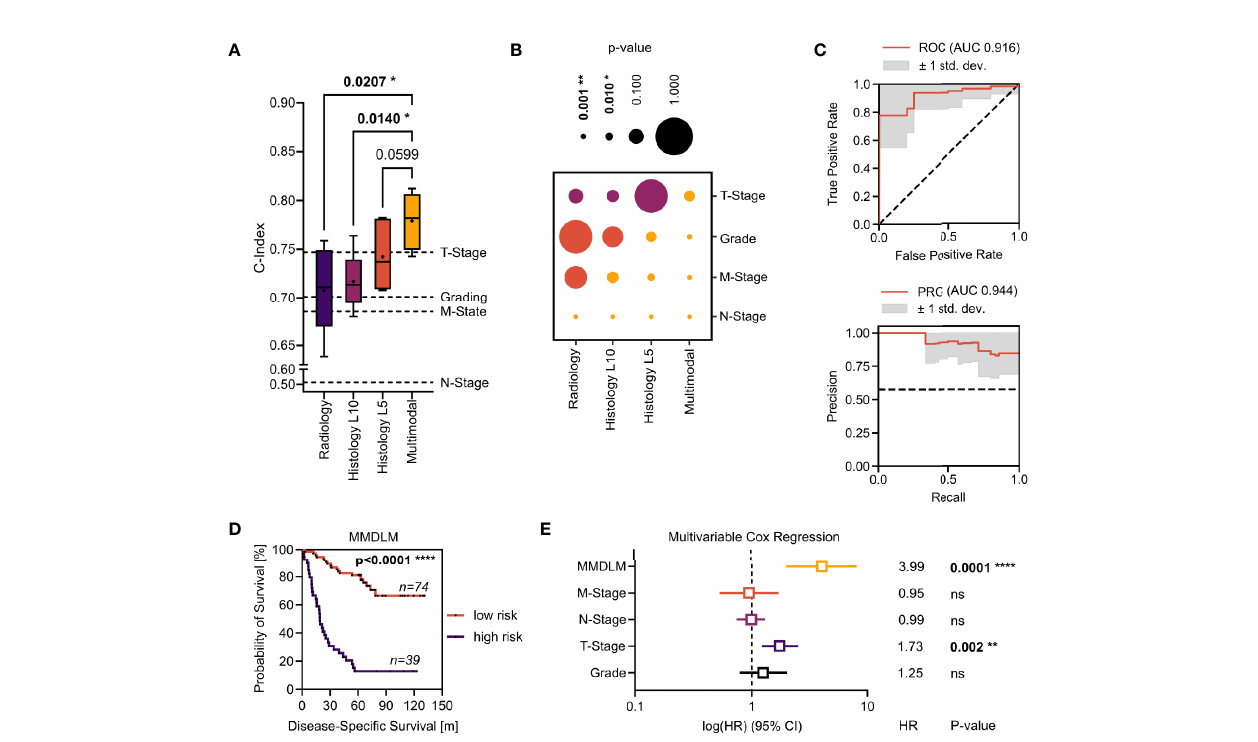
FIGURE 2 | Evaluation of the MMDLM for prognosis prediction in ccRCC. (A) C-index distribution of 6-fold cross validation. Dotted lines represent the C-index of the respective clinical attribute (Grading, T-Stage, N-Stage, M-Stage) of the whole cohort. RM one-way ANOVA with post-hoc Tukey HSD to correct for multiple comparisons was used to compare the groups. (B) P-value matrix of one-sample t test of each modality vs. each risk factor (yellow: signi fi cantly. higher, orange: higher, purple: lower). (C) Mean ROC (top) and PR curve (bottom) of 12-fold cross validation. (D) Kaplan – Meier-Curve after strati fi cation according to 5YSS by the MMDLM. (E) Forrest plot of multivariable Cox regression. HR, hazard ratio; CI, Con fi dence interval; Ns, not signi fi cant. *p = 0.01 – 0.05, **p = 0.001 – 0.01, ****p <